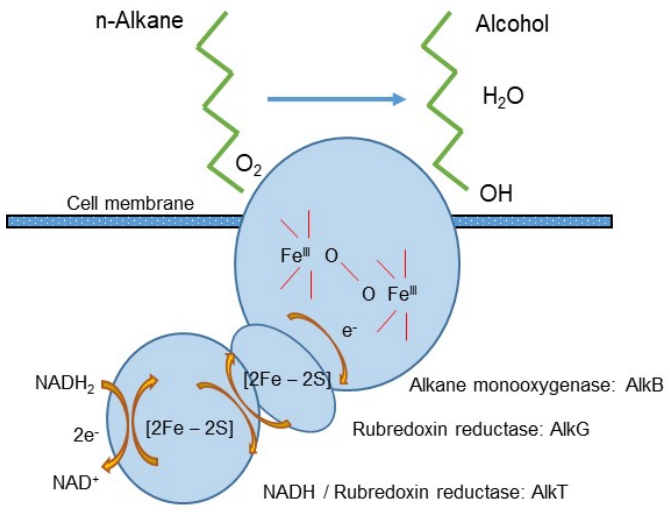
Figure 1. Rubredoxin-dependent enzyme system, an electron transfer system of alkane monooxygenase (AlkB ‐ type). Based on [2,4].